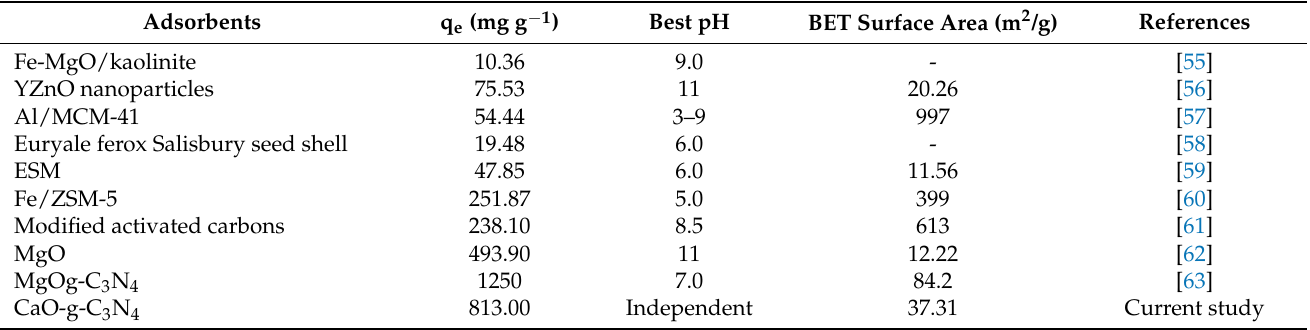
Table 3. Observation of adsorption capacities of the CaO-g-C 3 N 4 using various nanomaterial adsorbents.